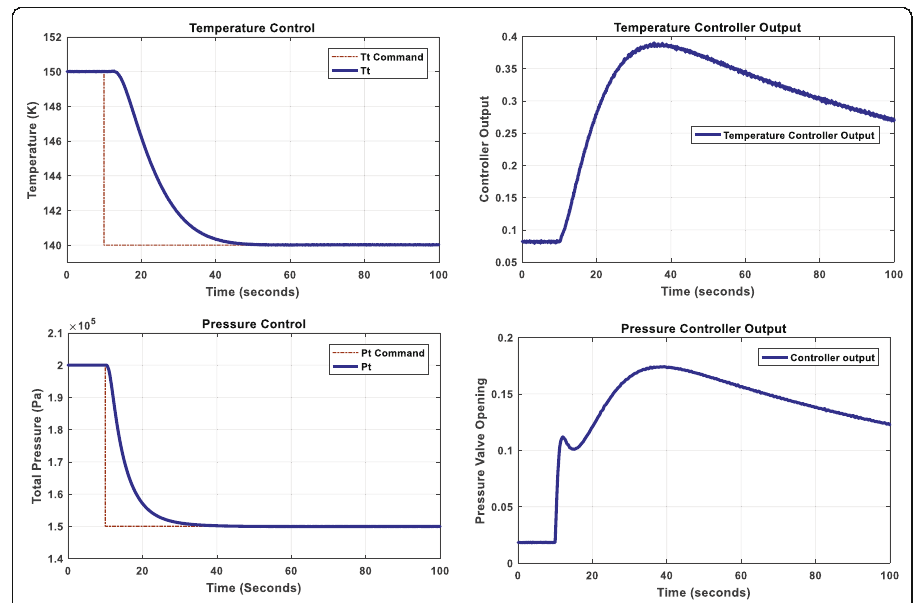
Fig. 6 Pressure step change control during the temperature step